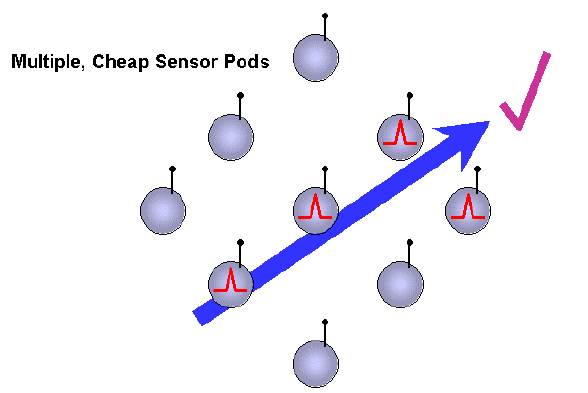
Figure 1. A single sensor does not give any information about spatio-temporal dynamics.